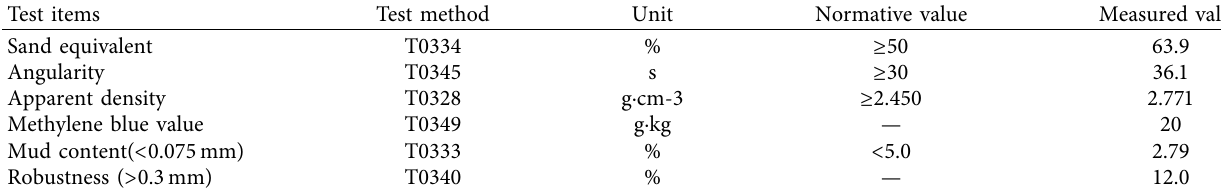
Table 2: Properties of fine aggregate.